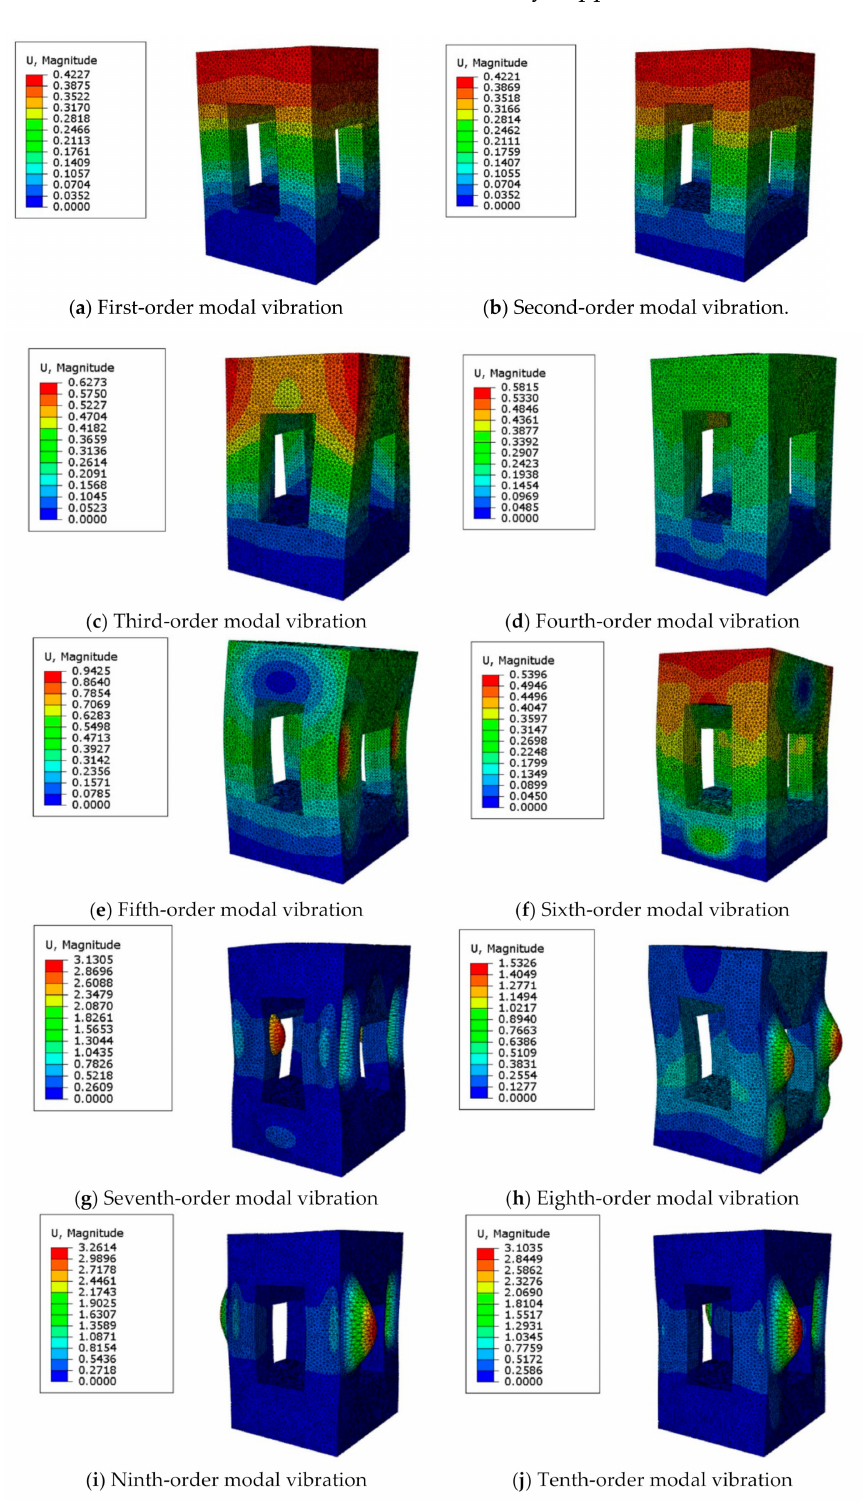
tenth-order modal vibrations, local vibration occurs on the column of the COF machine. The local vibration is drastic and noise will easily happen.